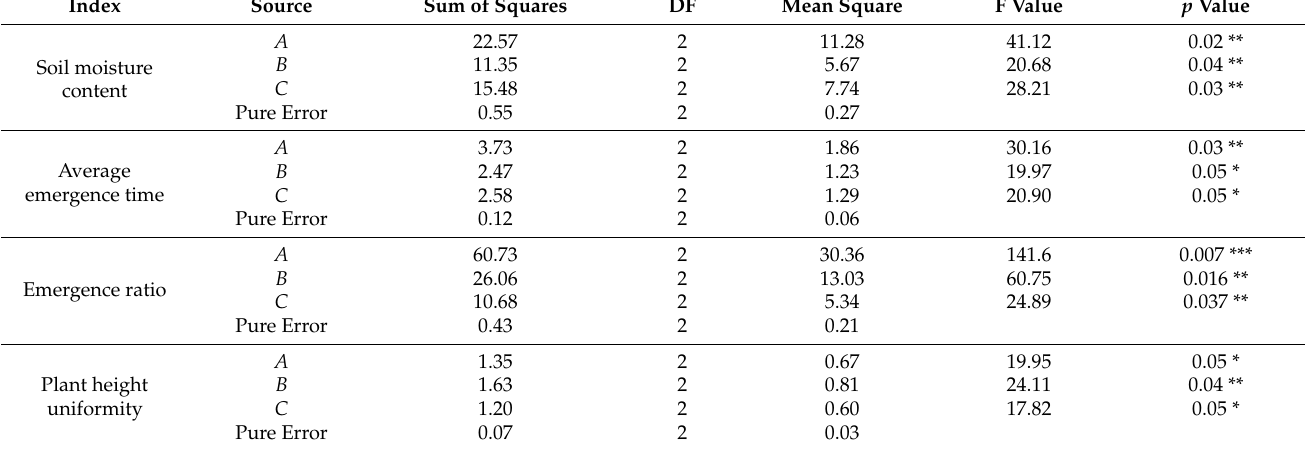
Table 4. The variance